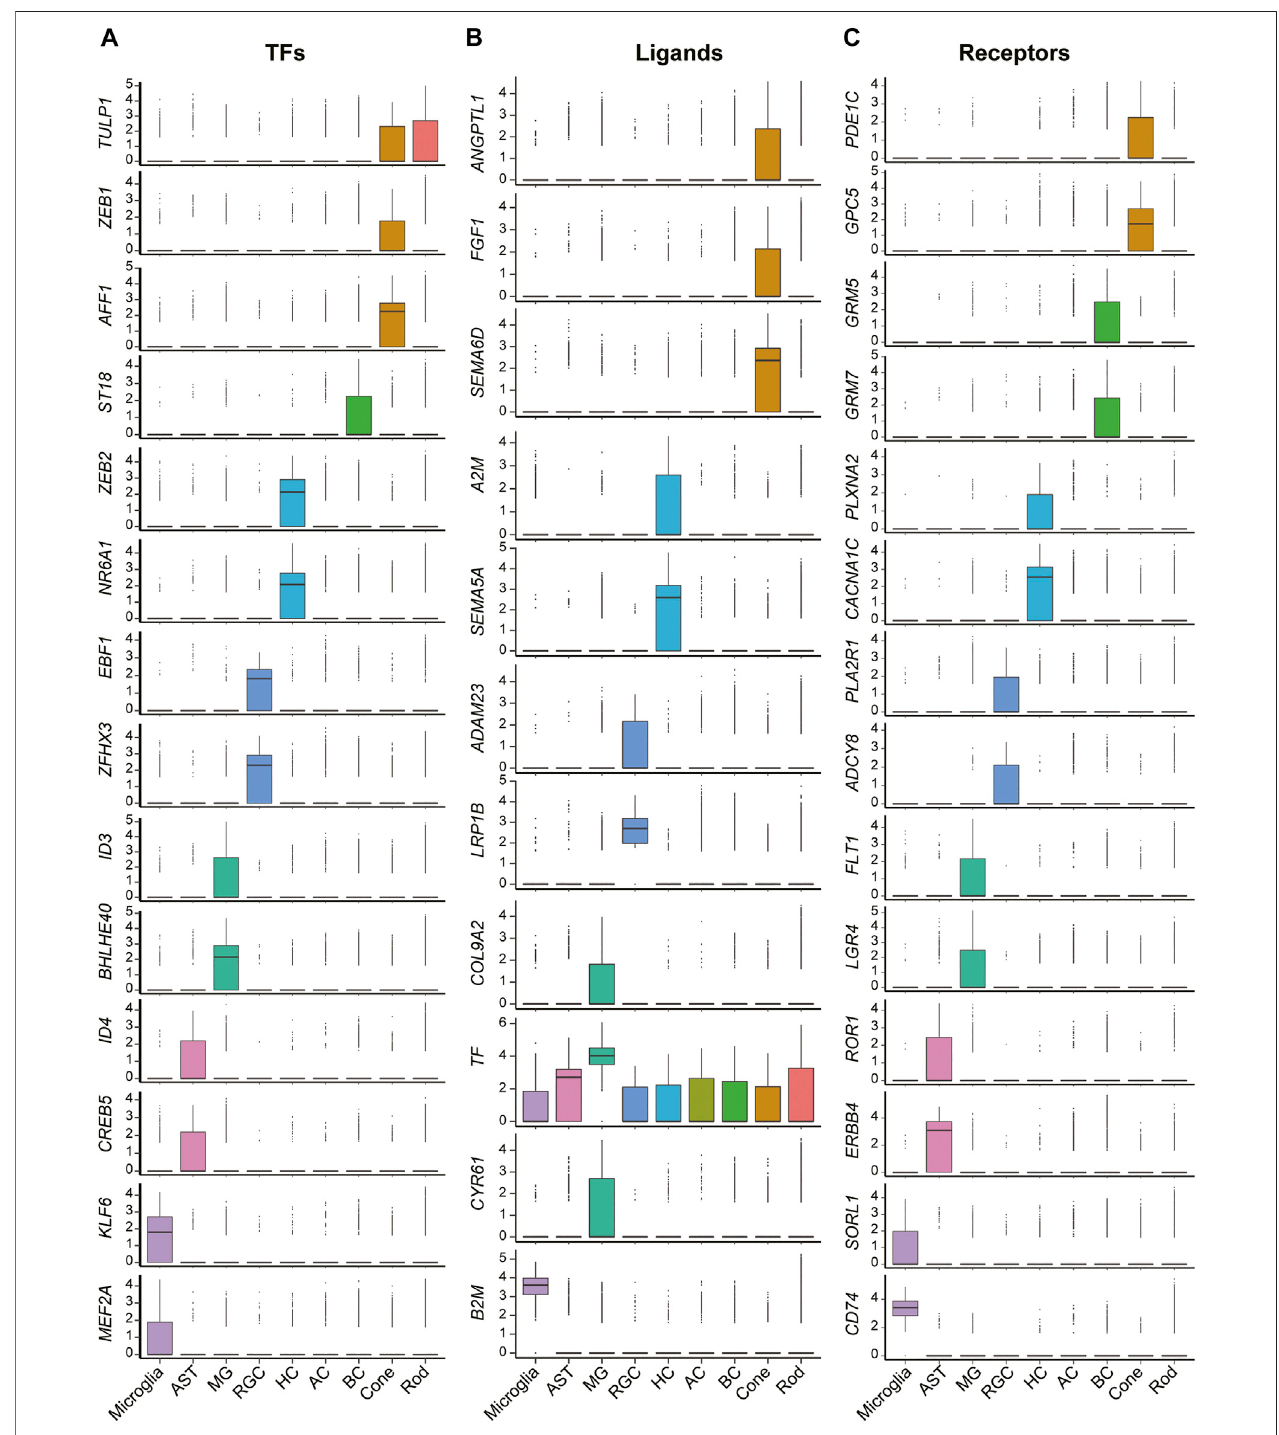
FIGURE2| Expressionpatternsofdifferentially expressed functionalgenesofcellsinretinas. (A) Boxplots showtheexpression patterns ofdifferentially expressed transcription factor encoding genes of each cell clusters. (B) Boxplots show the expression patterns of differentially expressed ligand encoding genes of each cell clusters. (C) Boxplots show the expression patterns of differentially expressed receptor encoding genes of each cell clusters.